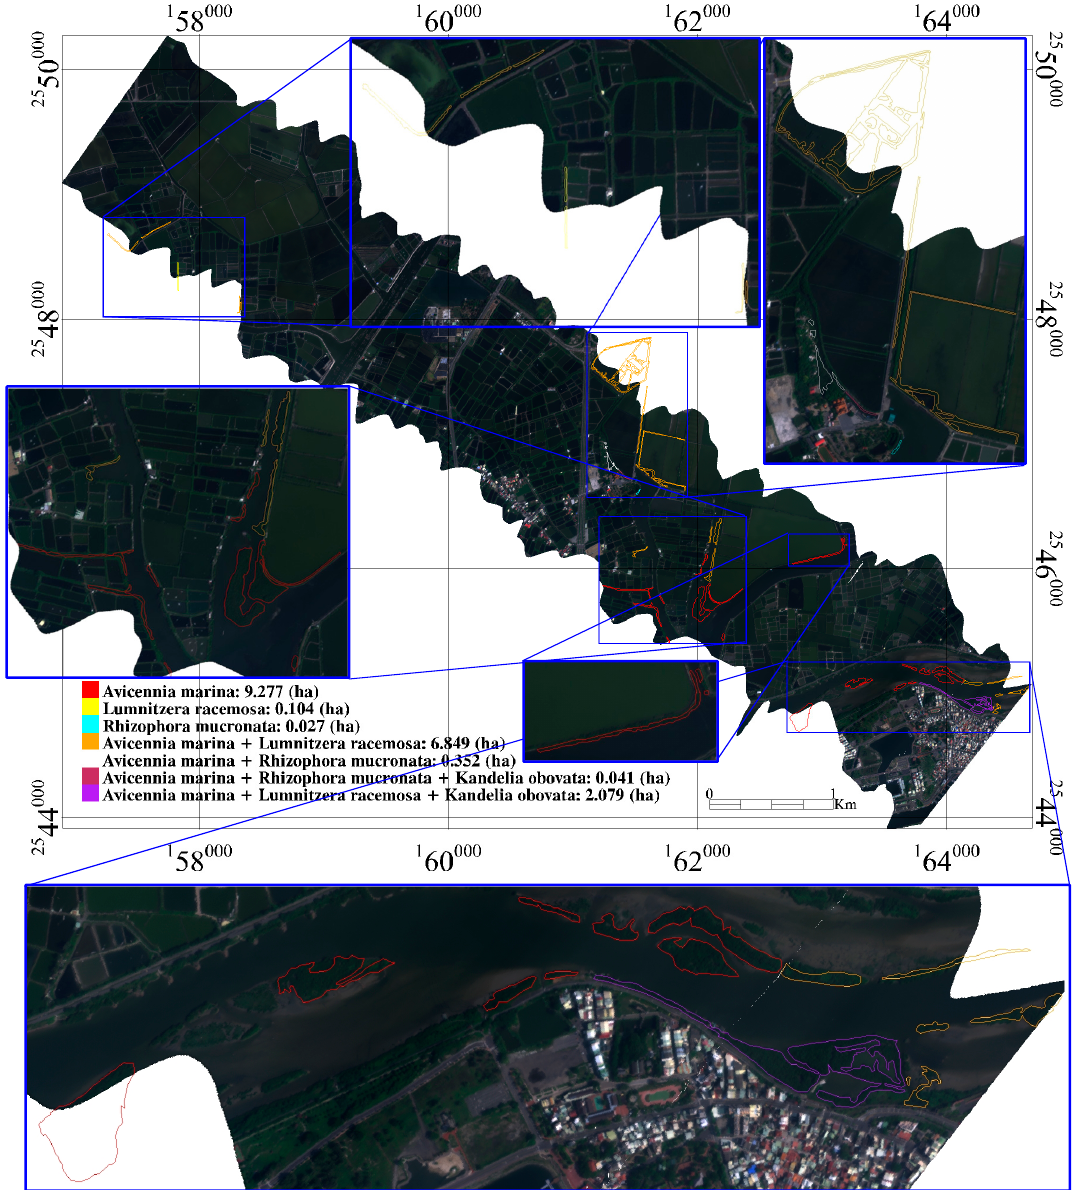
Figure 6. The map of mangrove distribution derived from the field investigation by Wang et al. [27] in 2011. Three classes of pure mangroves and four classes of mixed mangroves are overlaid on the FLAASH-corrected imagery of TNP with a legend showing both the species and area of each class. The five regions annotated by blue boxes are enlarged to clearly show the mangrove patches.